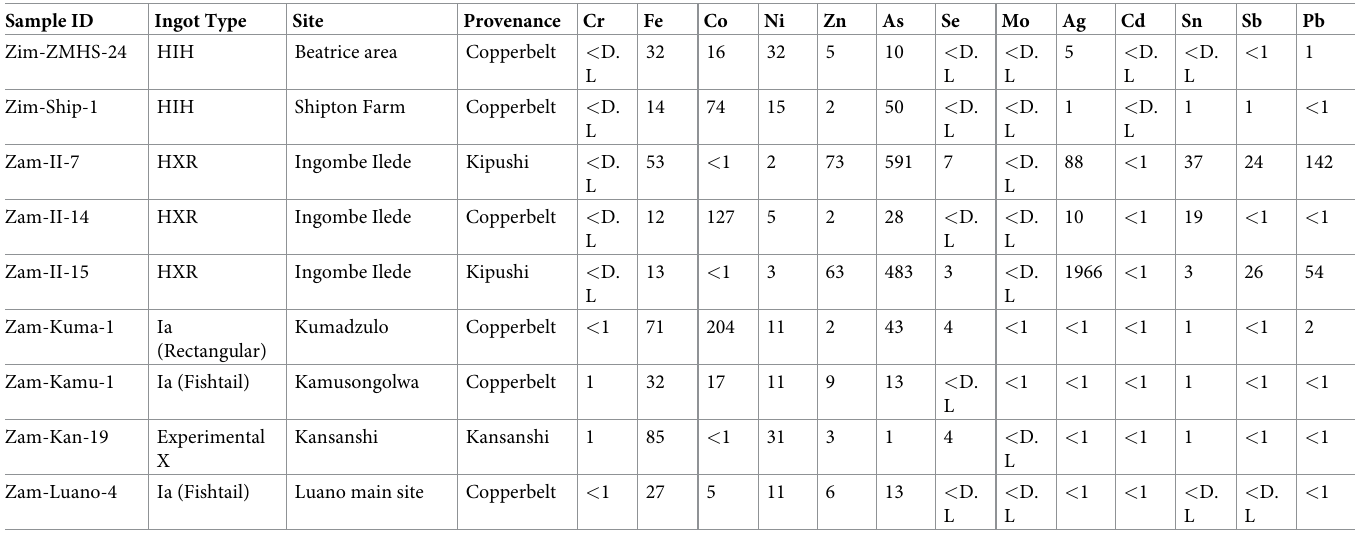
and allowed to reflux overnight at 120˚C. This solution was then separated using Bio-Rad dis- posable anion exchange columns loaded with Eichrom Sr-spec resin and eluted with various concentrations of twice distilled HCl and HNO to isolate the lead portion of each solution 3 [68, 69]. The resulting solution was then evaporated to dryness and 1 mL of 2% HNO was 3 added to each sample vial refluxed on a hotplate at 120˚C overnight. Samples were then ana- lyzed on the GV Instruments IsoProbe multi-collector inductively coupled plasma mass spec- trometer (MC-ICP-MS) housed in the Department of Geosciences and the University of Arizona ( Table 3 ). Data was corrected based on published values for the standard NBS981 [70] and all samples were empirically normalized with a thallium (Tl) spike using the exponen- tial law correction [63]. A mercury ( 204 Hg) correction is also typically applied to correct for interference on the 204 Pb signal, however Hg contents of the carrier gas were typically very low. Only the HIH sample Zim-ZMHS-18 required a mercury correction in this study. Proce- dural blanks were also measured, and all contained < 250 pg of